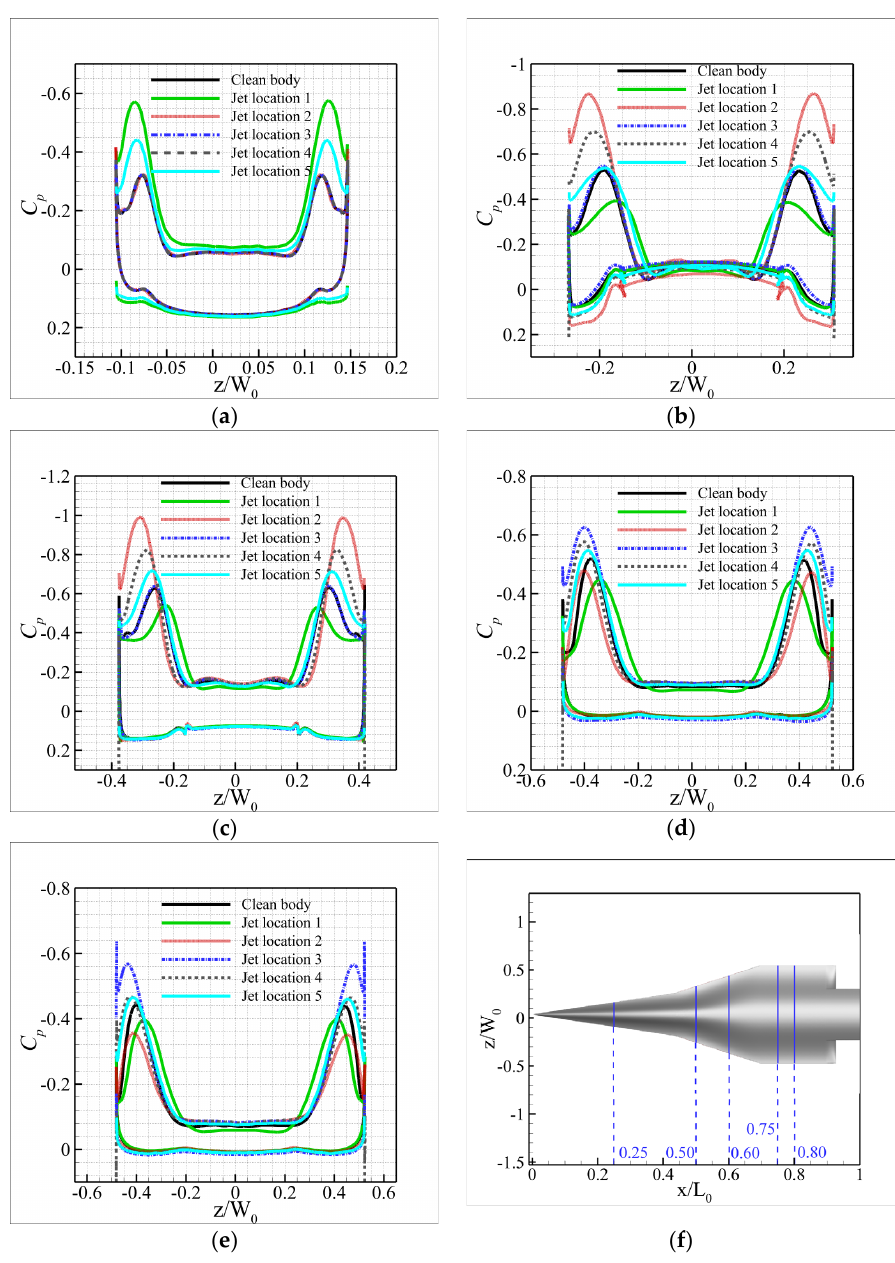
Figure 11. Comparison of the pressure coefficient distributions at the chosen cross-sections for different jet locations at α = 10 ◦ . ( a ) x / L 0 = 0.25; ( b ) x / L 0 = 0.5; ( c ) x / L 0 = 0.6; ( d ) x / L 0 = 0.75; ( e ) x / L 0 = 0.8; ( f ) Illustration of the